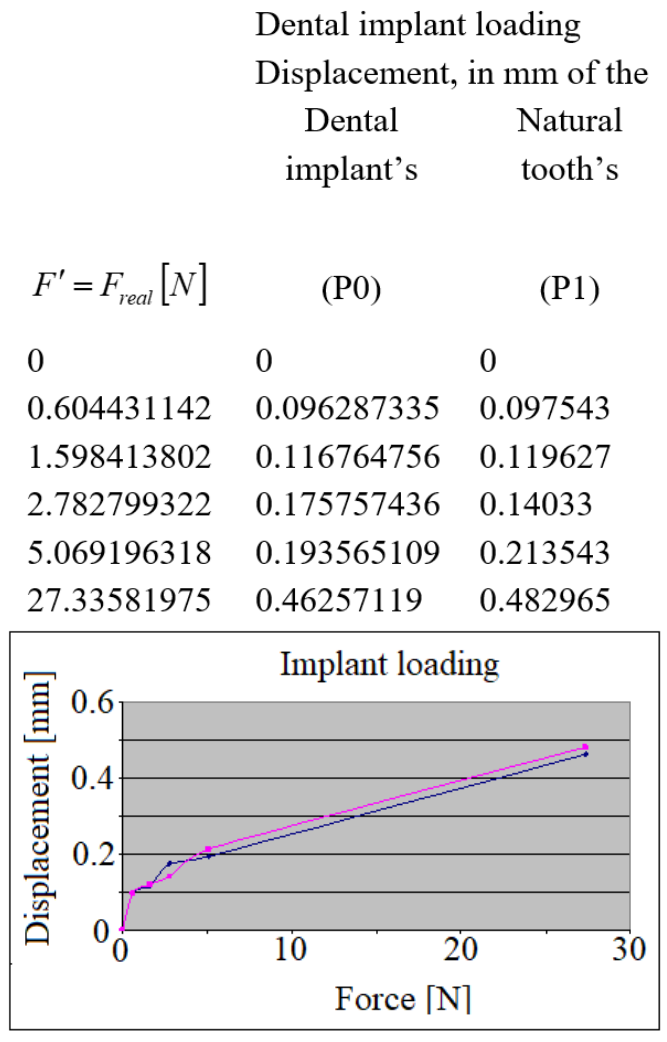
Figure 11. The relative displacement of the crowns during the implant’s loading.